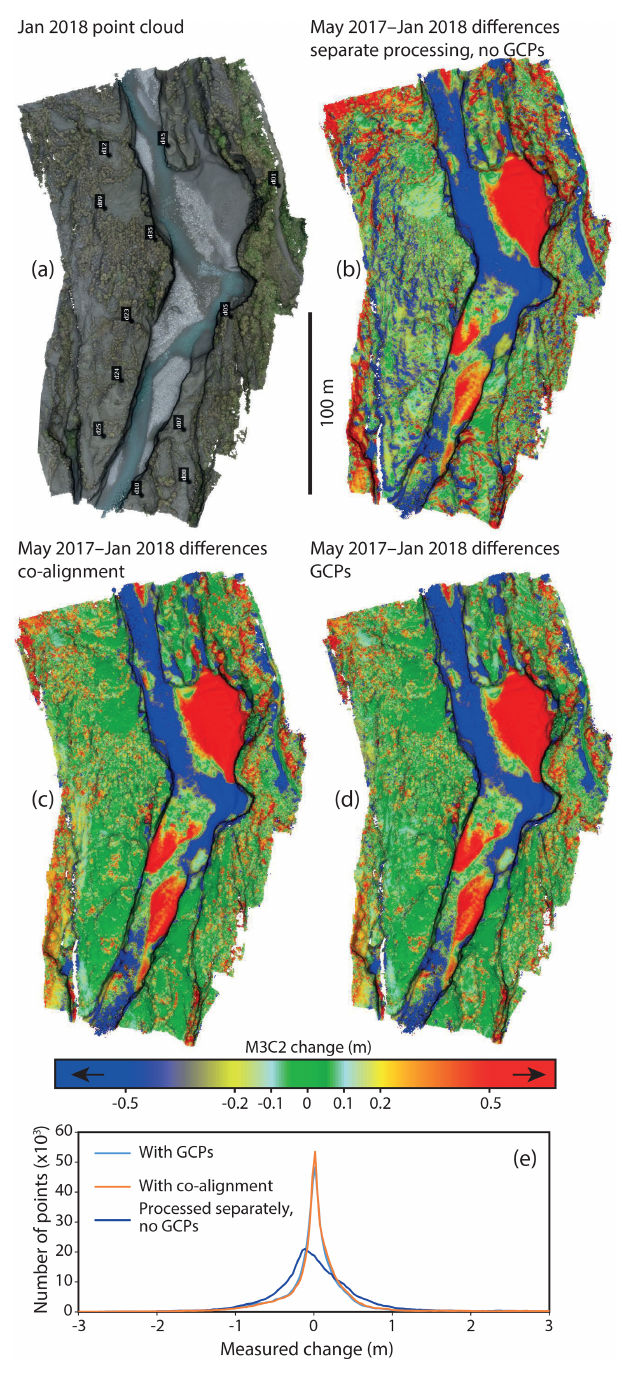
Figure 3. Daan River comparisons. (a) January 2018 point cloud with the ground control points shown. (b) M3C2 differences be- tween May 2017 and January 2018 point clouds processed sepa- rately with no GCPs. (c) M3C2 differences between May 2017 and January 2018 point clouds processed using the co-alignment work- flow. (d) M3C2 differences between May 2017 and January 2018 point clouds processed separately using GCPs. (e) Density curves of the measured changes shown in panels (b) – (d)